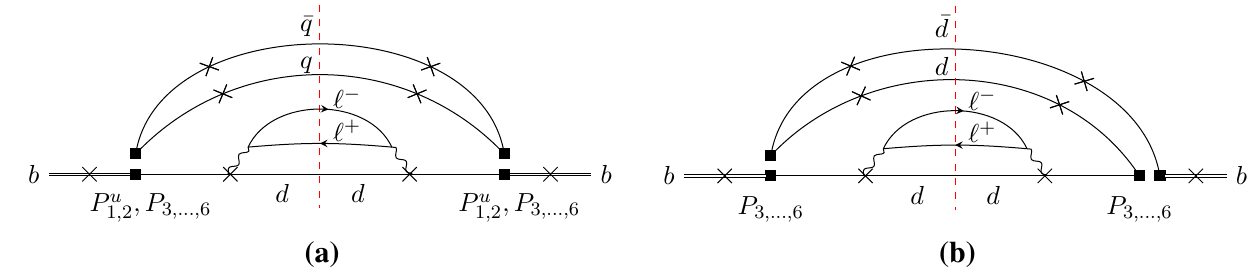
, P Fig. 1 Contributions of the operators P u 3 ,..., 6 to the five-body decay, where the lepton pair can be emitted and absorbed from any of the 1 , 2 crosses. Insertion ( b ) is only present for penguin operators P 3 ,..., 6 with q =